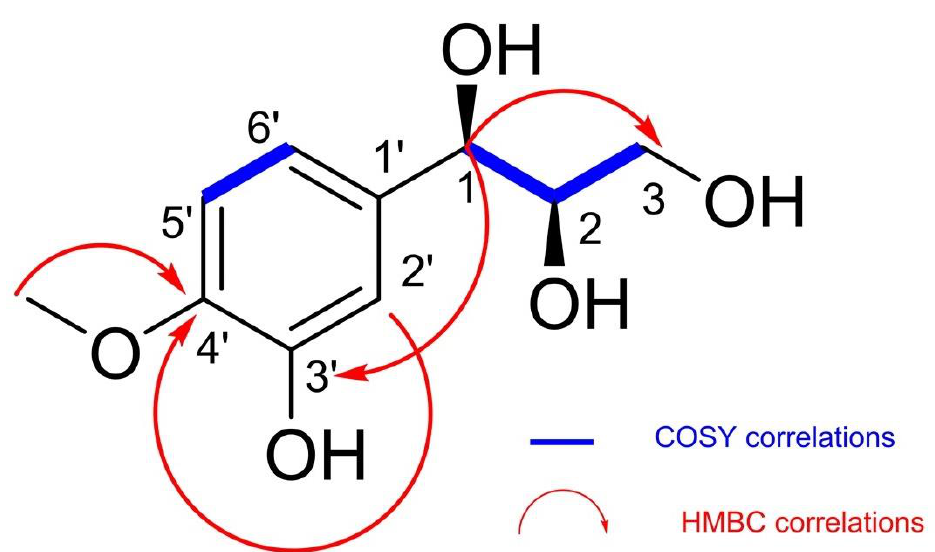
Figure 1. Key 1H-1H COSY and HMBC correlations of compound 1 .